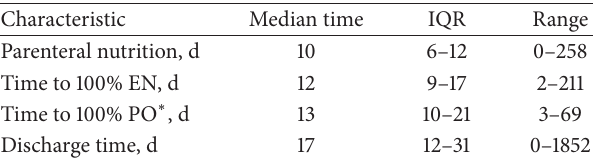
Table 2: Nutritional characteristics of the